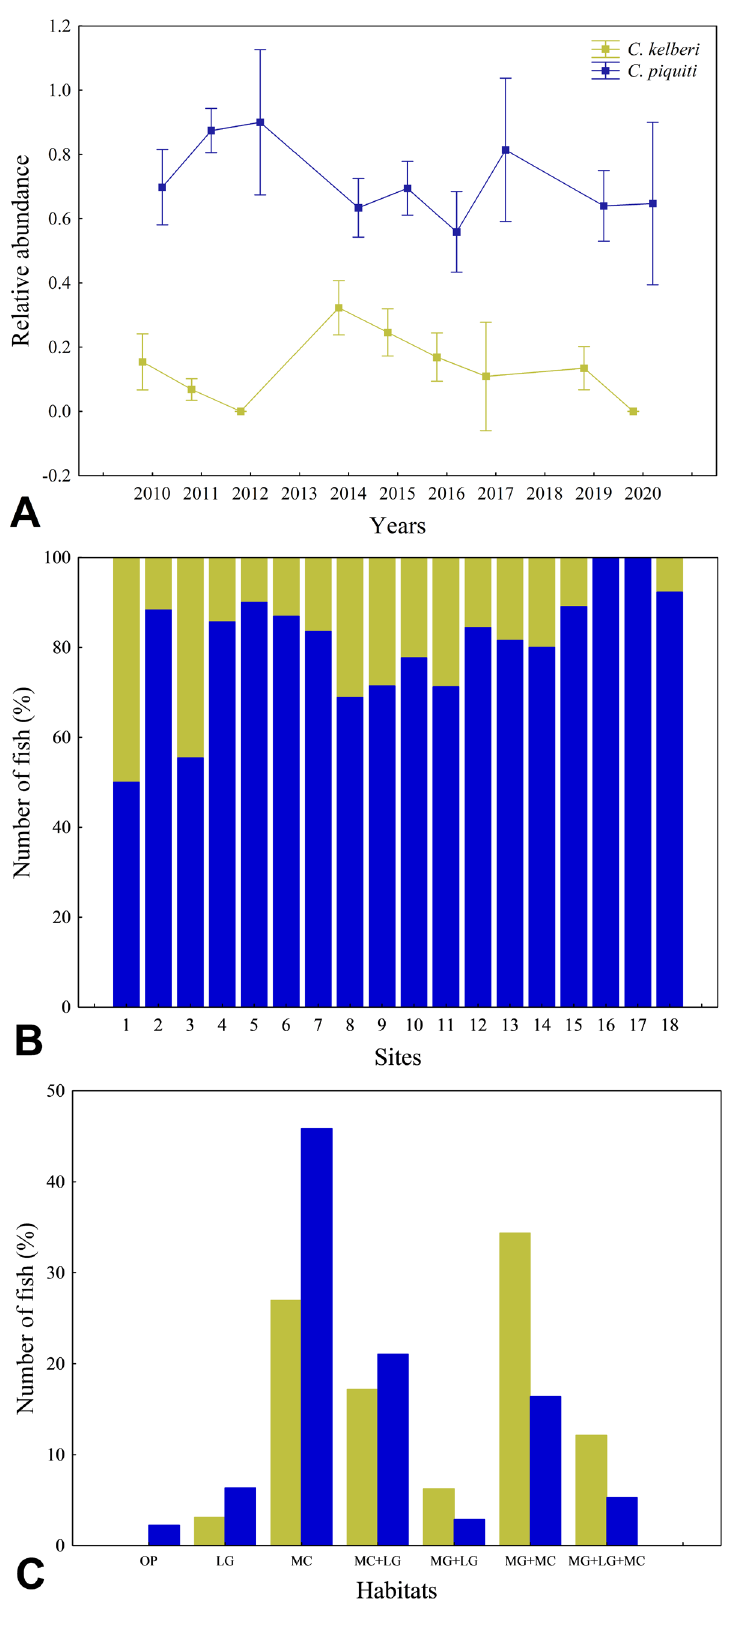
FIGURE 2 | Temporal and spatial variation in the abundance of Cichla kelberi and C. piquiti . A. Mean relative abundance over the years; whiskers represent 95% confidence intervals. B. Relative abundance at each sampling site. C. Habitat use considering the number (%) of fish captured in each habitat (and some combinations). OP = open areas; MG = margins; MCR = macrophytes; LG =